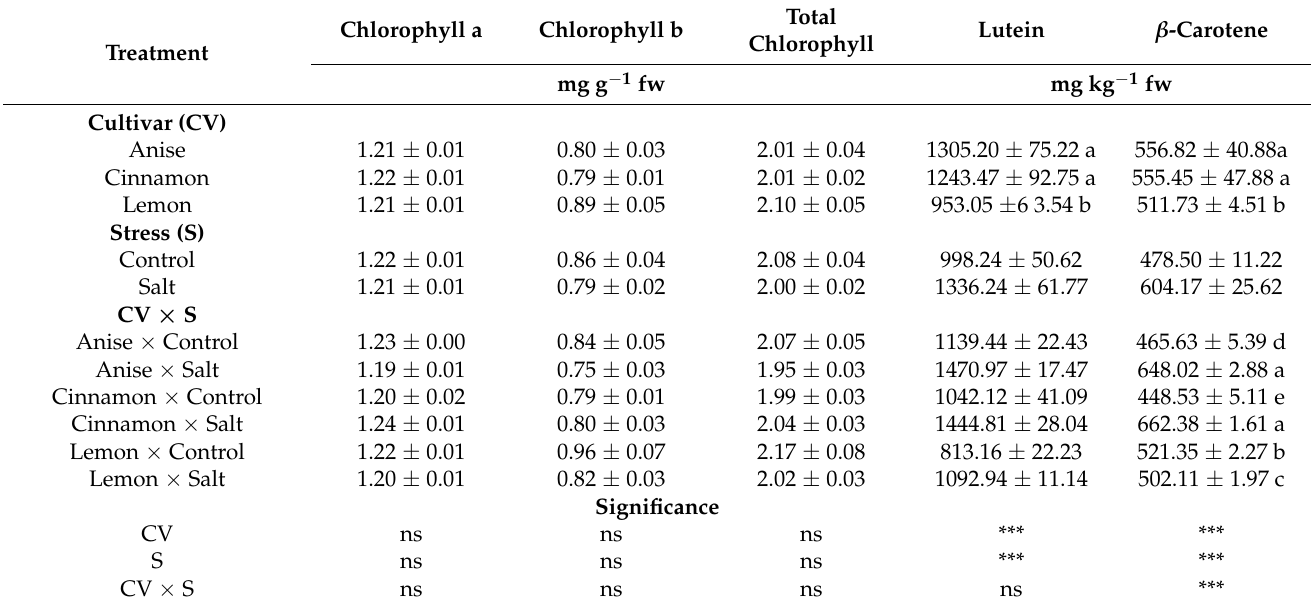
Data are mean values ± standard error, n = 3. Mean comparisons were performed by Tukey HSD test for CV and by t -Test for S. Different letters within each column indicate significant mean differences. ns and *** denote non-significant or significant effects at p ≤ 0.001,